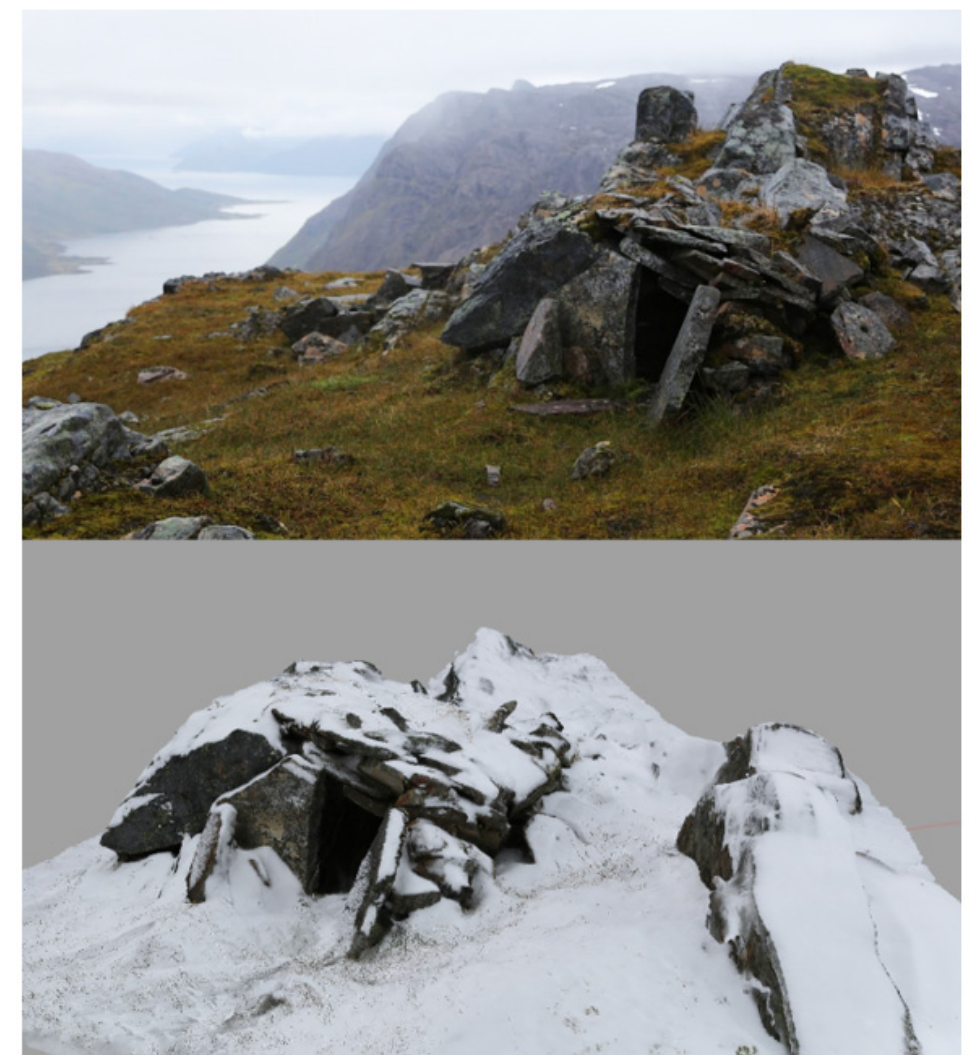
Figure 7. ( top ) Shelter on top of the pass created from naturally occurring slabs (photograph by G. Caspari); ( bottom ) 3D model after the first snow fall illustrating the shelter’s protective function against wind and